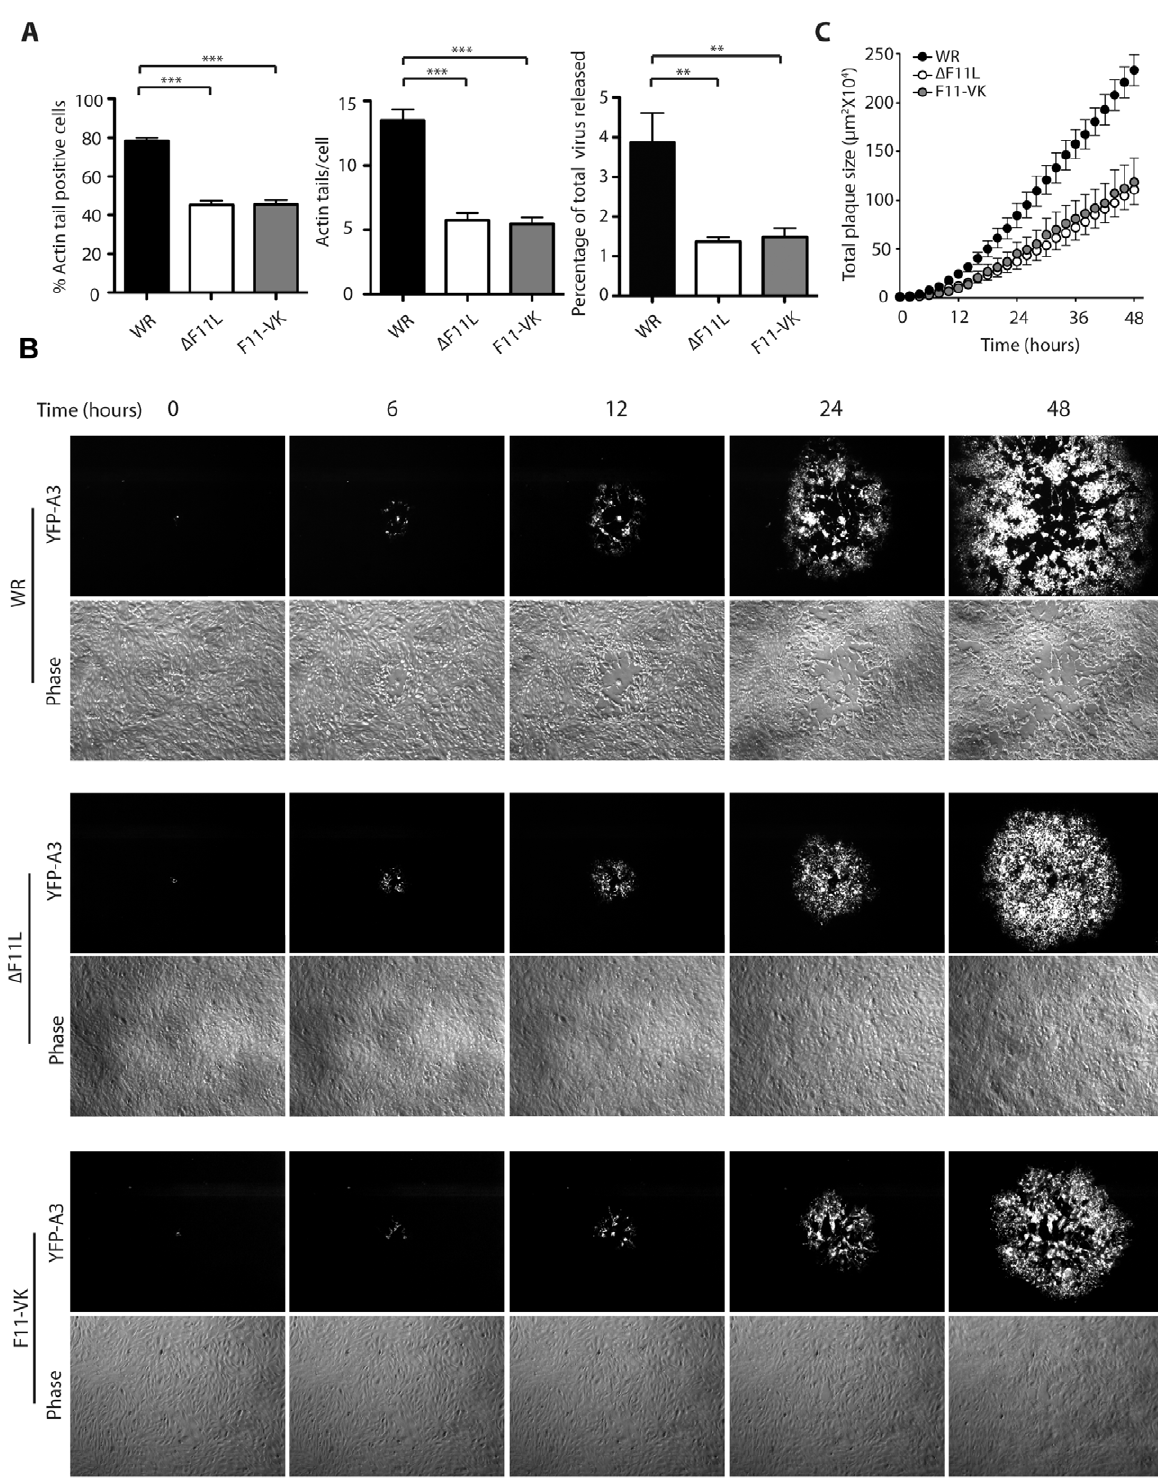
Figure 3. F11 enhances the cell-to-cell spread of vaccinia virus. ( A ) Quantitative analysis reveals that D F11L or F11-VK produce significantly less actin tails than WR at 8 hours post infection. A lack of inhibition of RhoA signalling also results in a , 2.5 fold reduction in the % of infectious virus released into the media from D F11L or F11-VK as compared to WR infected cells. Error bars represent SEM from 4 independent experiments and ** indicates P , 0.01 and *** indicates P , 0.001. ( B ) Phase contrast and fluorescence movie stills of a developing plaque at the indicated time reveals that WR spreads faster in a monolayer of BS-C-1 cells than the D F11L or F11-VK viruses (Movies S1, S2, S3). The central clearing seen in WR and F11-VK plaques is due to a loss of cell-cell adhesion and viral induced cell migration. ( C ) Quantitative analysis of the rate of spread of the indicated virus during 48 hours. Error bars indicate SEM from 6 independent plaques.